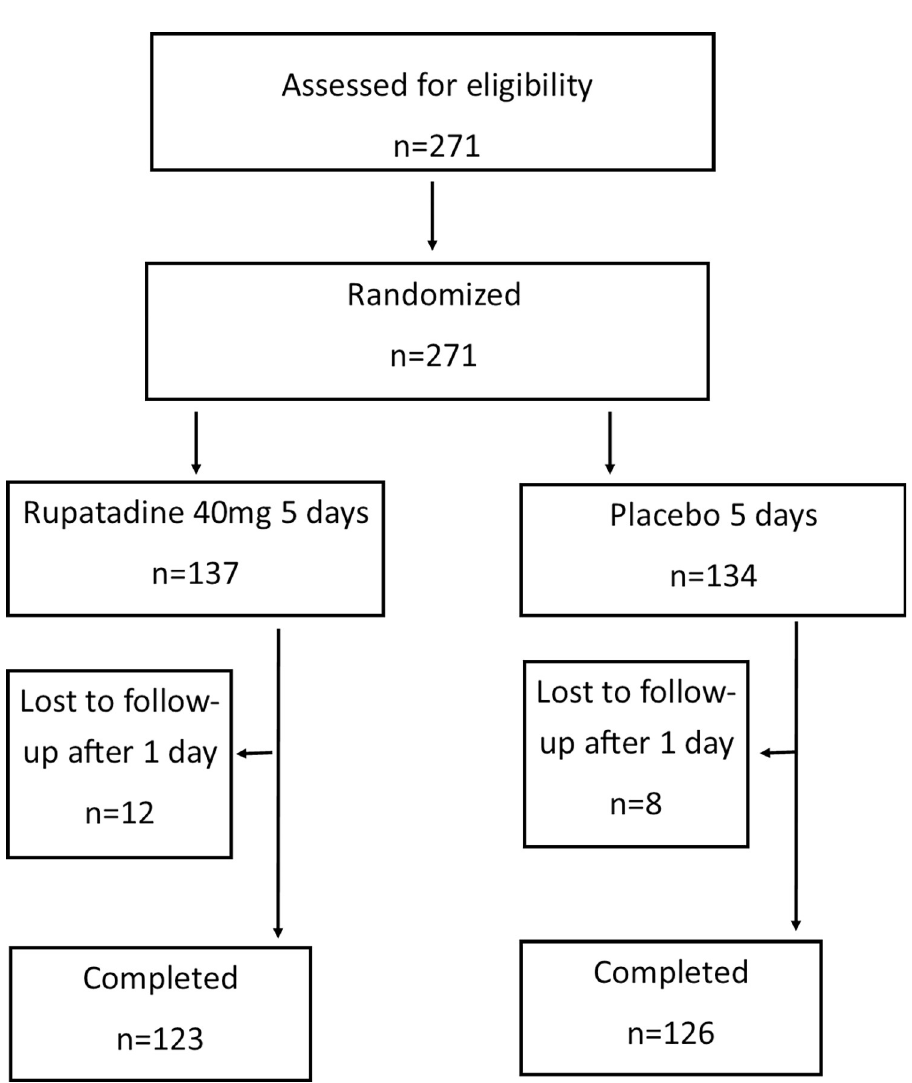
Fig 1. Flow chart of the study showing recruitment to the two different arms of treatment. 271 individuals were assessed for eligibility and randomised. 12 individuals in the rupatadine arm and 8 individuals in the placebo arm were lost to follow